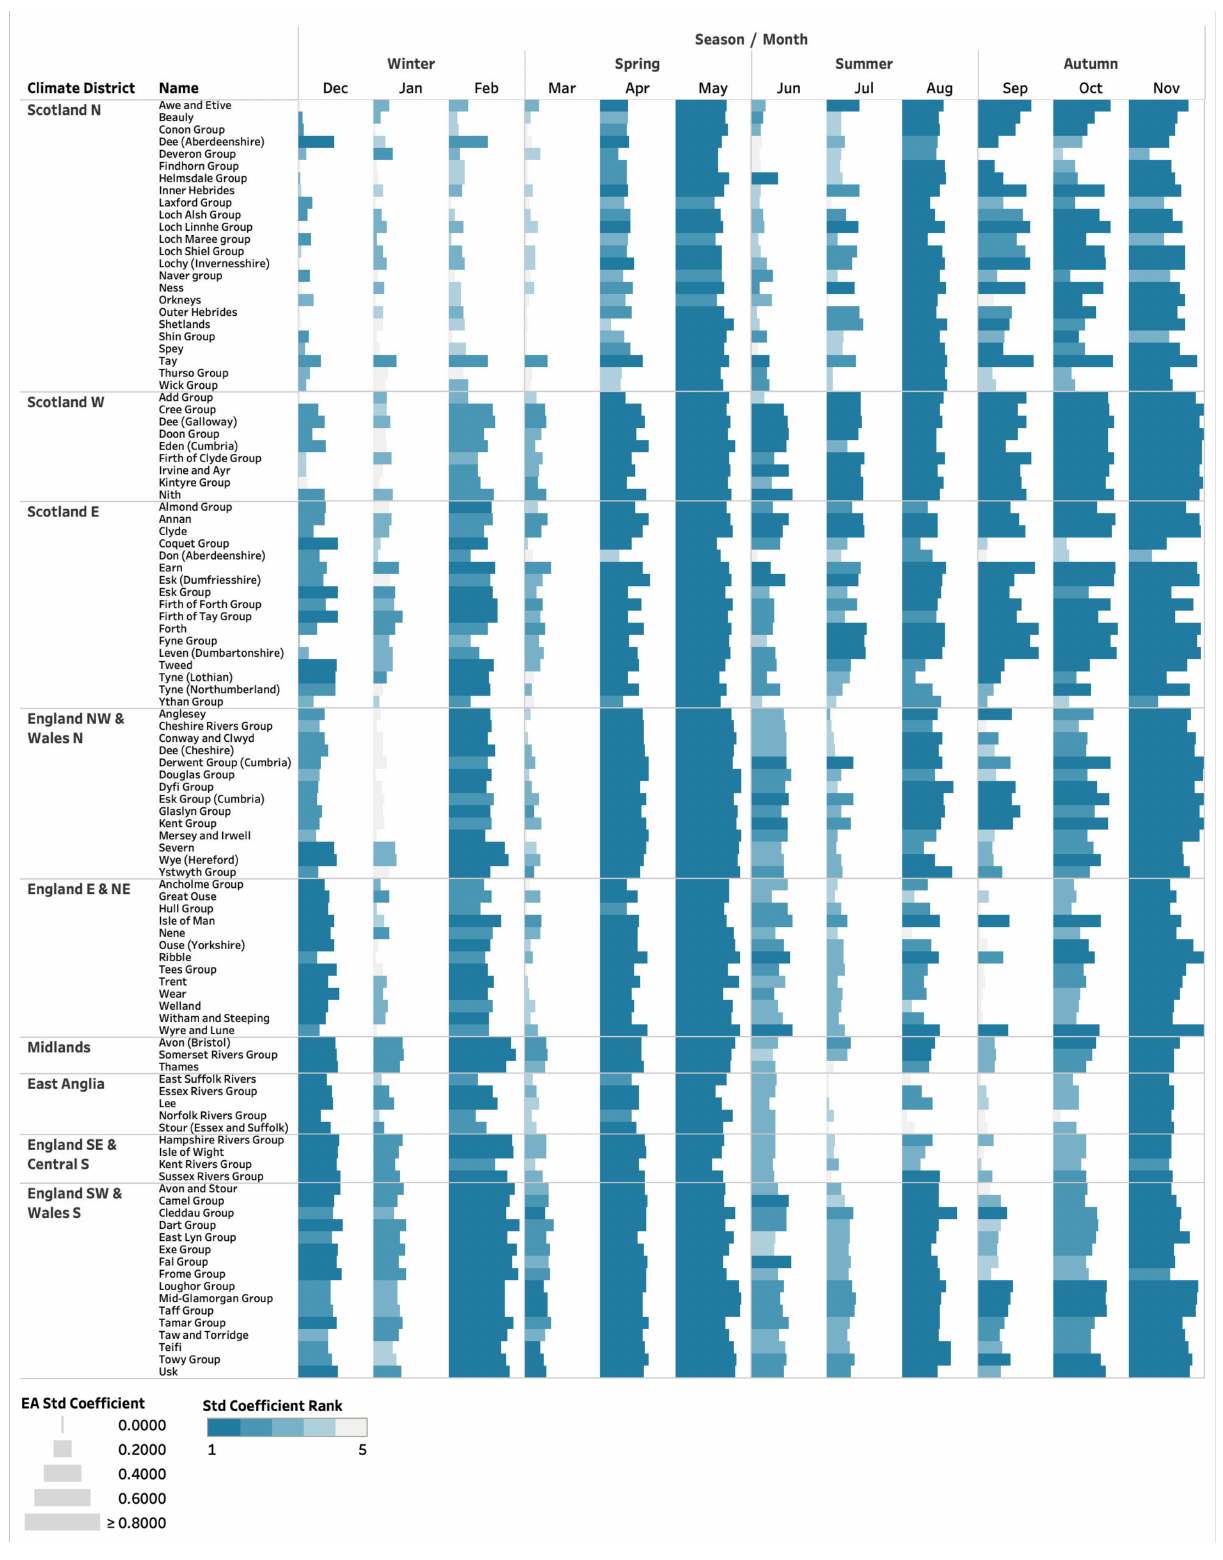
Figure A5. Rank of the EA Standardised Coefficient. Colour represents the rank, with darker colours signifying greater influence (higher rank). Size is dependent on the magnitude of the